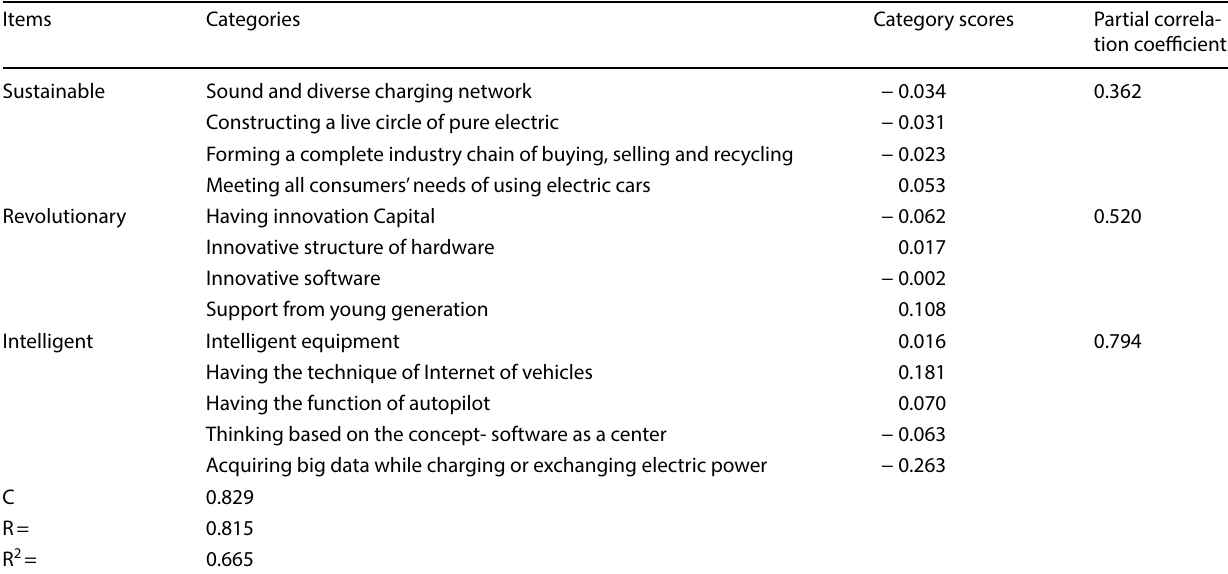
Table 6 The partial correlation coefficients, the category scores, and the coefficient of determination for the factor of “visionary”